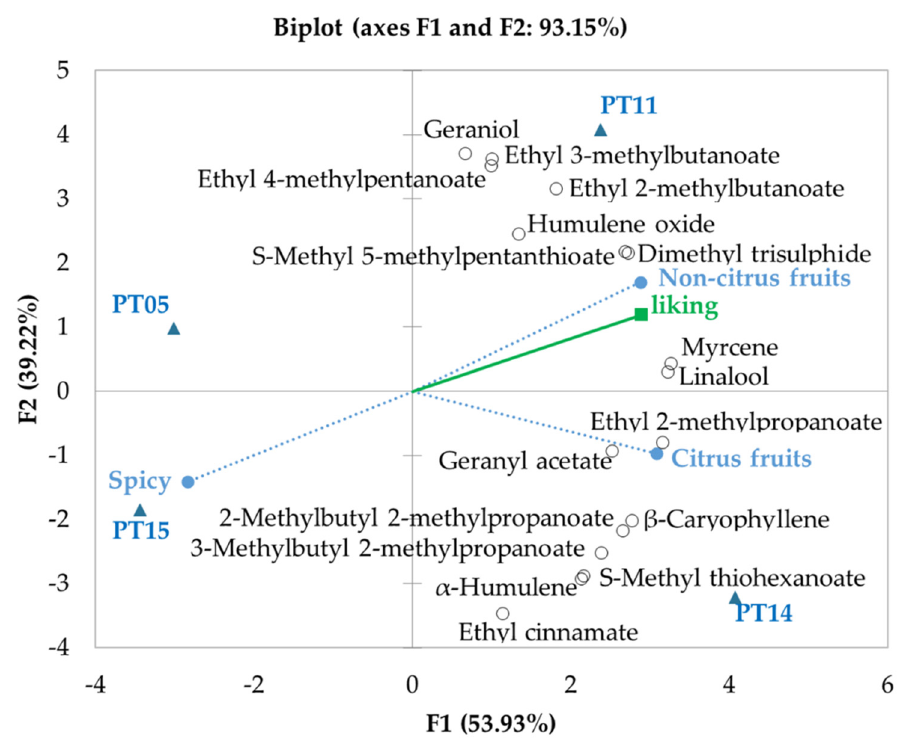
Figure 3. Principal Component Analysis (PCA) biplots of sensory attributes (blue circle) and volatile compounds content (black open circles) of dry-hopped beers (blue triangles) used as active variables. Liking scores (green square) were used as a passive (supplementary) variable.